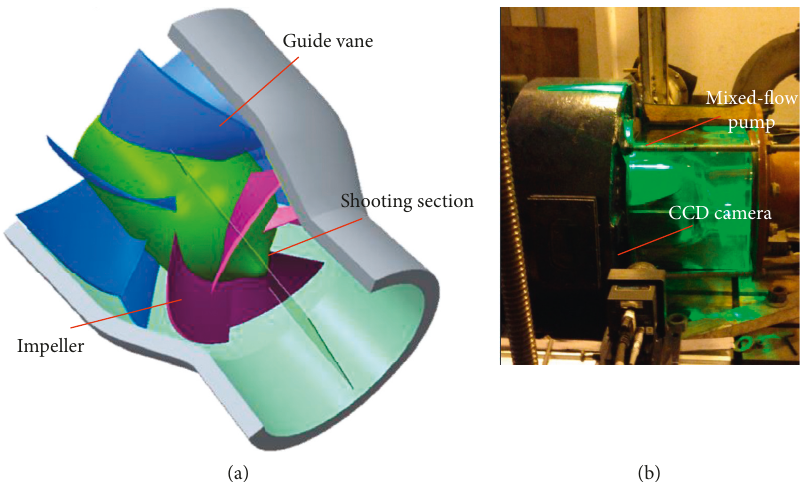
Figure 5: Sketch map of shooting section (a) and the layout of PIV experimental test